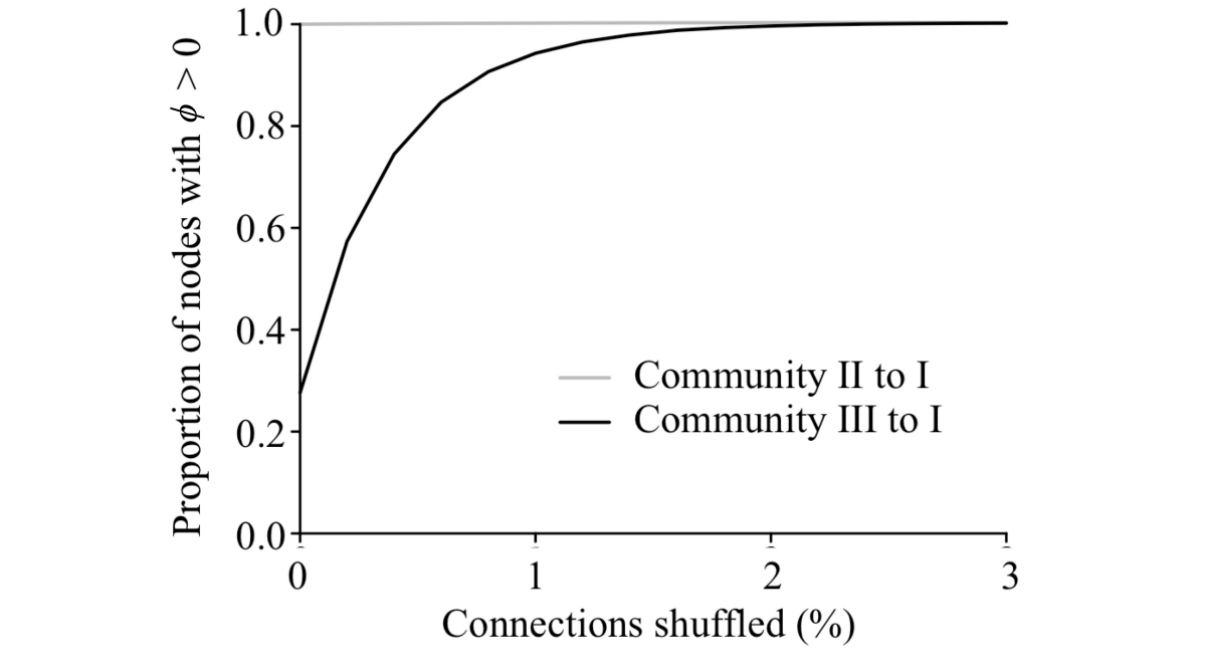
Figure 8. The proportion of nodes in community II (gray line) and community III (black line) with the ability to spark an epidemic (i.e., ϕ >0; see Multimedia Appendix 1) in module I across varying levels of network shuffling at R 0